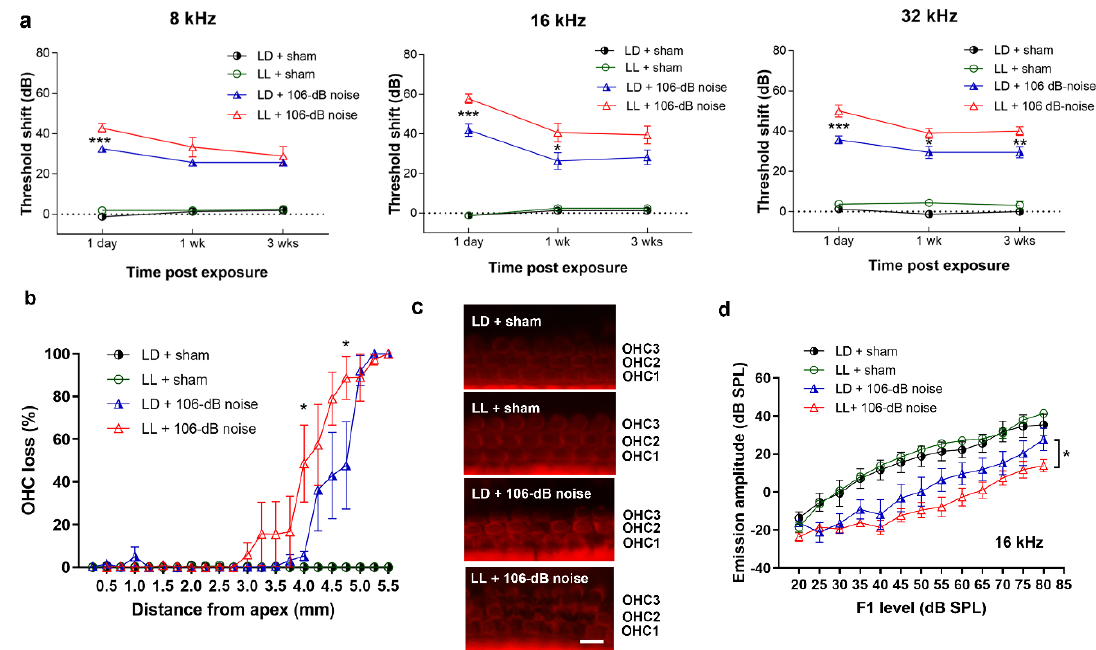
Figure 5. The ABR threshold shifts, OHC (outer hair cell) counts, and DPOAE 2F1-F2 amplitudes in the LD and LL groups after 106 dB noise exposure. ( a ) Significantly higher threshold shifts in the LL group were found over 8 kHz at 1 day postexposure, over 16 kHz at 1 day and 1 week postexposure, and over 32 kHz at 1 day, 1 week, and 3 weeks postexposure. Data are mean ± SEM ( n = 8–9 for each group). * p < 0.05, ** p < 0.01, *** p < 0.001 for LD + 106 dB noise vs. LL + 106 dB noise. ( b ) The LL group showed a higher percentage of outer hair cell (OHC) loss in the basal segment than the LD group after exposure to the 106 dB noise. Data are mean ± SEM (LD + sham, n = 7; LL + sham, n = 6; LD + 106 dB noise, n = 5; LL + 106 dB noise, n = 6). * p < 0.05 for LD + 106 dB noise vs. LL + 106 dB noise. ( c ). Representative images of OHCs in the basal segment (about 4 mm from apex) after different treatments. OHC 1, 2, and 3 indicate three rows of OHCs. Scale bar = 10 µm ( d ) DPOAE 2F1-F2 amplitudes were decreased in the LL group after exposure to the 106 dB noise at 16 kHz. Data are mean ± SEM. * p < 0.05 for LL + 106 dB noise vs. LD + 106 dB.